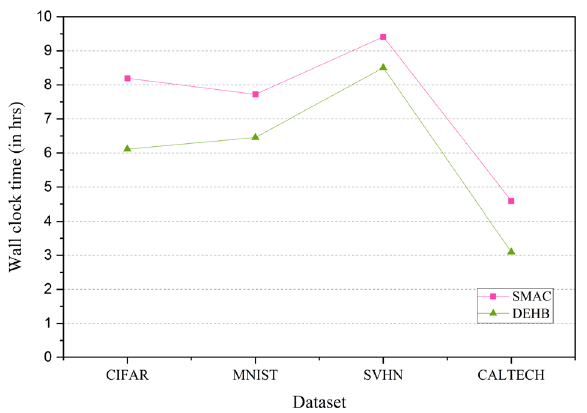
Figure 5. Wallclock time comparison plot of AlexNet model across the datasets—CIFAR, MNIST, SVHN and CALTECH. The HPO packages used here are SMAC and DEHB. SMAC is a BO package and DEHB combines DE and Hyperband.